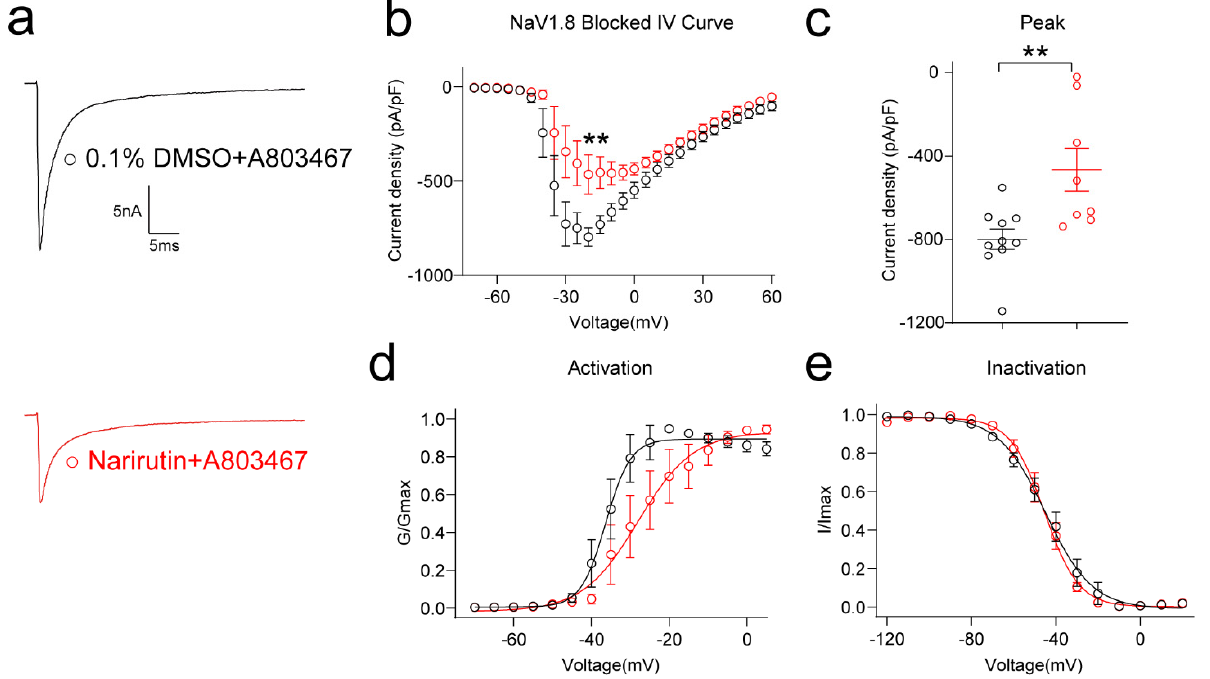
Figure 5. Effect of Narirutin on sodium currents after blocking Na v 1.8 currents by A-803467. ( a ) Representative traces of the Na + currents from DRG sensory neurons after being treated with 0.1% DMSO + 500 nM A-803467 or 20 μ M Narirutin + 500 nM A-803467. Currents were evoked by 200 ms pulse between − 70 and +60 mV. Summary of ( b ) the normalized (pA/pF) sodium current density versus voltage relationship and ( c ) peak Na + current density (Na v 1.8 blocked) at − 10 mV from DRG neurons treated as indicated. Boltzmann fits for normalized conductance, G/Gmax voltage relationships for voltage-dependent ( d ) activation, and ( e ) inactivation sensory neurons. The half-maximal activation (V 1/2 ) and slope values ( k ) for activation and inactivation are summarized in Table 1. Data are expressed as means ± SEM. Asterisks indicate statistical significance compared with vehicle treatment (** p < 0.01, Mann–Whitney test, n > 9 cells per condition).